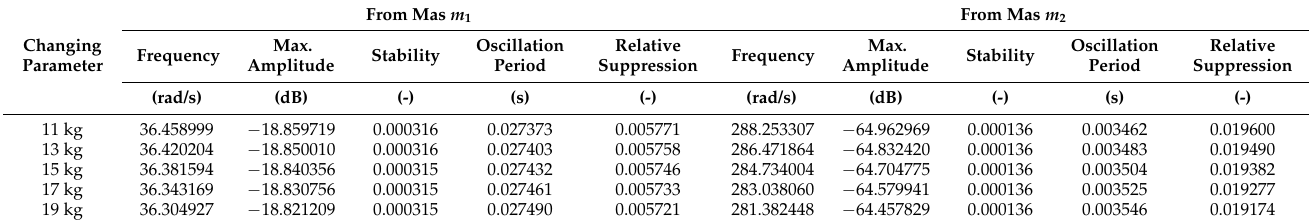
Table 6. The values of the parameters read from the graphs shown in Figure 12.